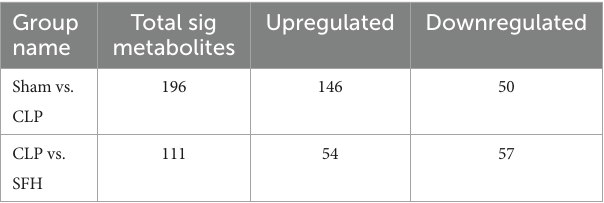
TABLE 1 The statistical table on the number of differential